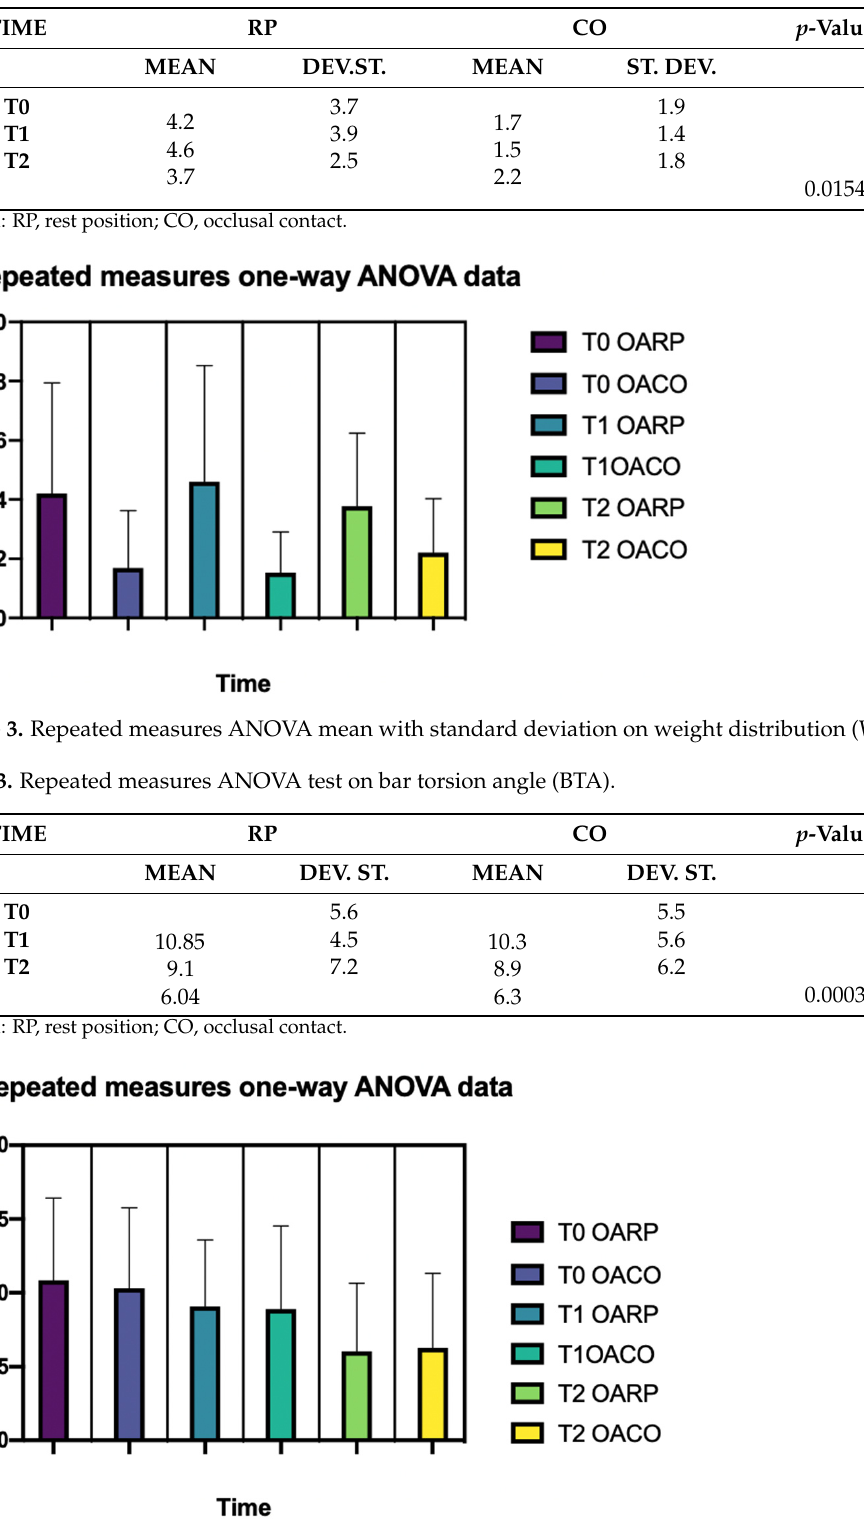
Figure 4. Repeated measures ANOVA mean with standard deviation on bar torsion angle (BTA).